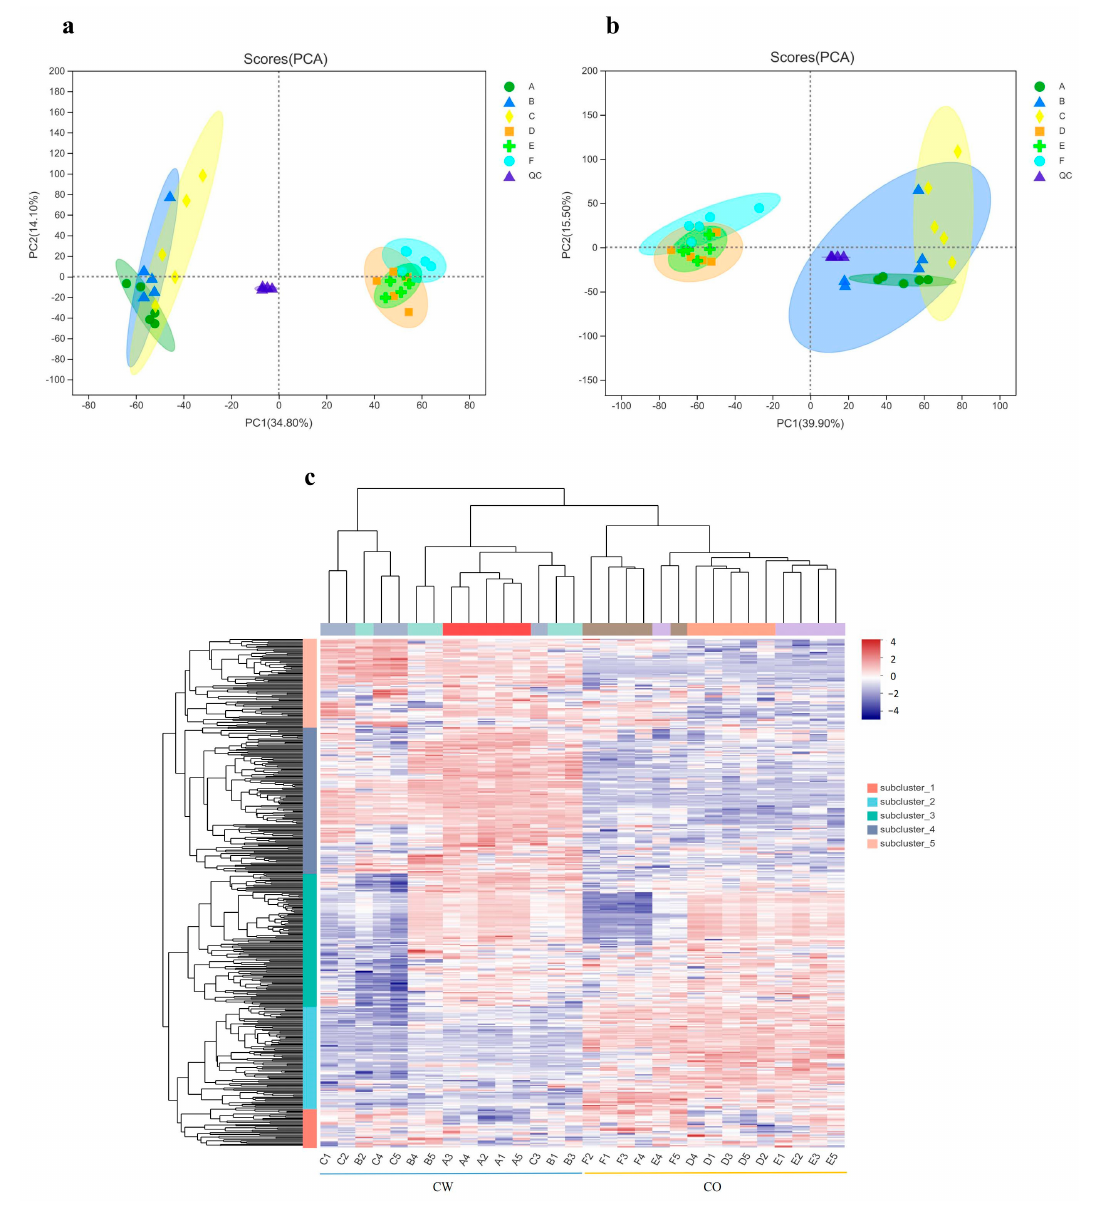
Figure 4. Principal component analysis (PCA) and hierarchical cluster analysis (HCA) of the metabolites distribution among different treatments. ( a ) PCA plot of positive mode, ( b ) PCA plot of negative mode, ( c ) clustering heat map of all metabolites in all samples by HCA, different colors are the values obtained after normalization of the metabolite content, red bars represent high abundance, whereas blue bars are low abundance. Five repetitions were taken for per treatment. CW, Camellia weiningensis ; CO, Camellia oleifera ; A, CW treated with 20 ◦ C; B, CW treated with 4 ◦ C; C, CW treated with − 4 ◦ C; D, CO treated with 20 ◦ C; E, CO treated with 4 ◦ C; F, CO treated with − 4 ◦ C. Quality control (QC) sample was the mixture of all samples.